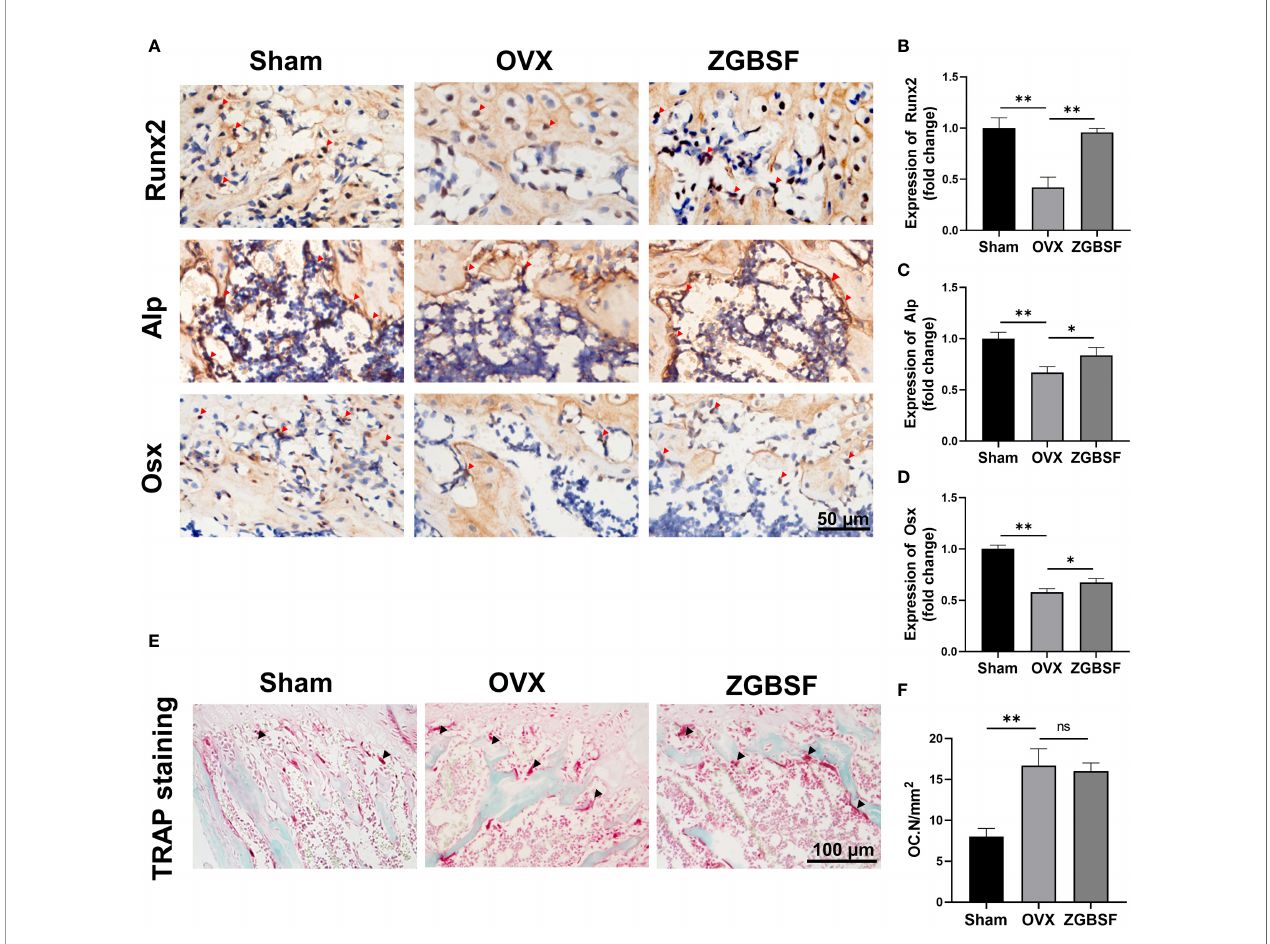
FIGURE 5 | ZGBSF promotes osteogenesis and fails to inhibit osteoclastogenesis. (A) Immunohistochemistry of Runx2, Alp, and Osx of the distal femur. Red arrows indicated the high expression of Runx2, Alp, and Osx. (B – D) The quanti fi cation of Runx2, Alp, and Osx expression. (E) TRAP staining of the distal femur. (F) The number of osteoclasts (OC.N/mm 2 ). The arrows represented the positive expression. Data were presented as mean ± SEM of three independent experiments. * P < 0.05, ** P < 0.01, NS indicated no signi fi cant